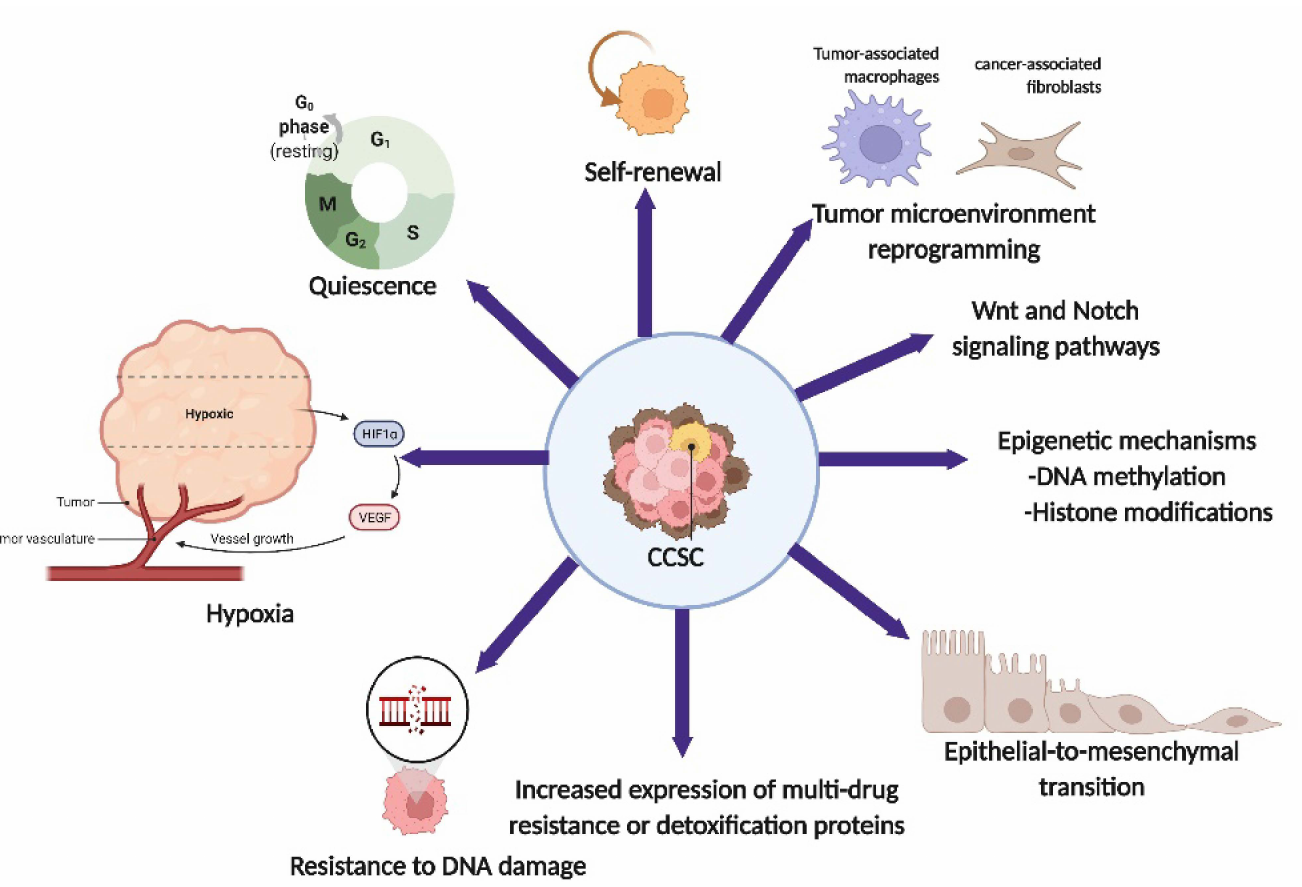
Figure 1. Illustration summarizing various mechanisms in cervical cancer stem cell (CCSC) con- tributing to chemoresistance. CSCs can contribute to chemoresistance through various mechanisms including quiescence, self-renewal, tumor microenvironment reprogramming, signaling pathways, epigenetic mechanisms, epithelial-to-mesenchymal transition (EMT), enhanced expression of multi- drug resistance or detoxification proteins, resistance to DNA damage, and